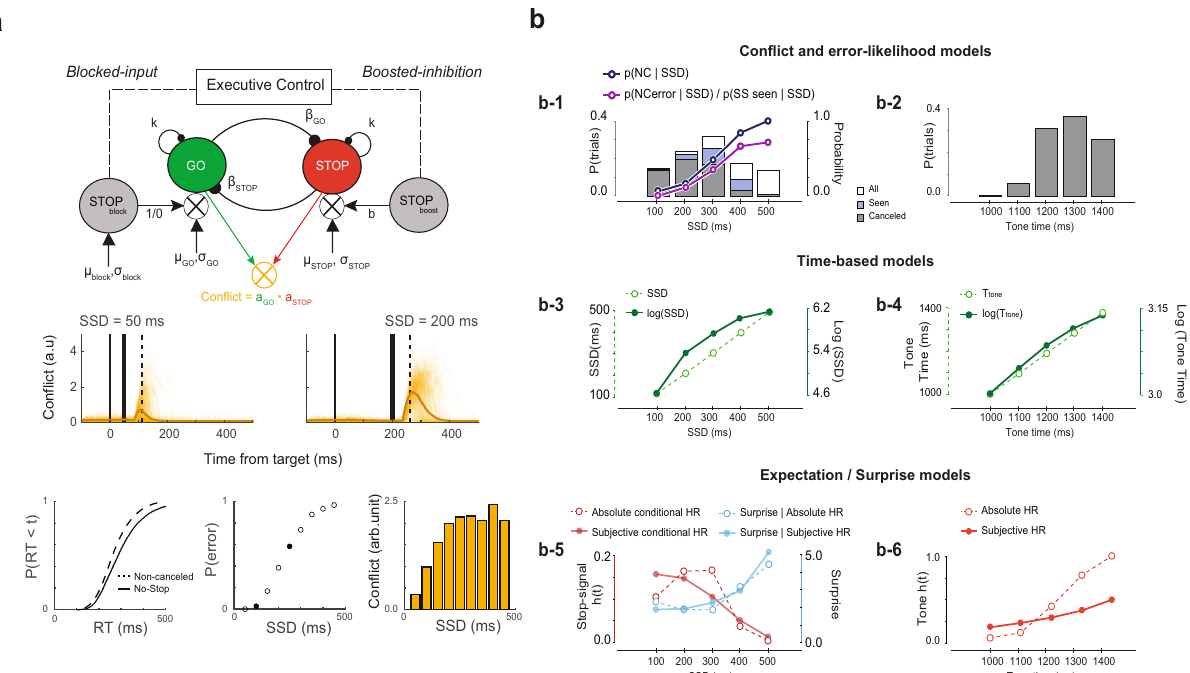
Fig. 2 | Models of neural modulation. a Interactive race model architecture. In interactive race architectures 29,30 GO and STOP units are racing, competing responsechannels,sotheproductoftheirco-activationmeasuresresponsecon fl ict in this task. In simulations with parameters simulating observed RT and p (NC|SSD) values (lower panels) the instantaneous product of a GO * a STOP of individual (thin) and average (thick) increases around and peaks after SSRT (middle panels). The product of the activation of GO and STOP units producing countermanding per- formance is proportional to p (NC|SSD) (lower right panel). Consequently, p (NC| SSD)isaneffectiveproxyforthecon fl ictmeasure. b Quantitiesrelatedtodifferent behavioral and task parameters that arise from the variability in SSD and T tone are shownfor a representative session. These quantitiesde fi ned models with different predictionsaboutvariationsinneuralactivity.Con fl ictanderror-likelihoodmodels ( b-1 )werebasedontheproportionsofstop-signaltrials(leftordinate)inwhichthe saccade was successfully canceled (gray bars), those in which the stop-signal was seen because of RT>SSD (SS seen ; blue bars) and all stop-signal trials (white bars).